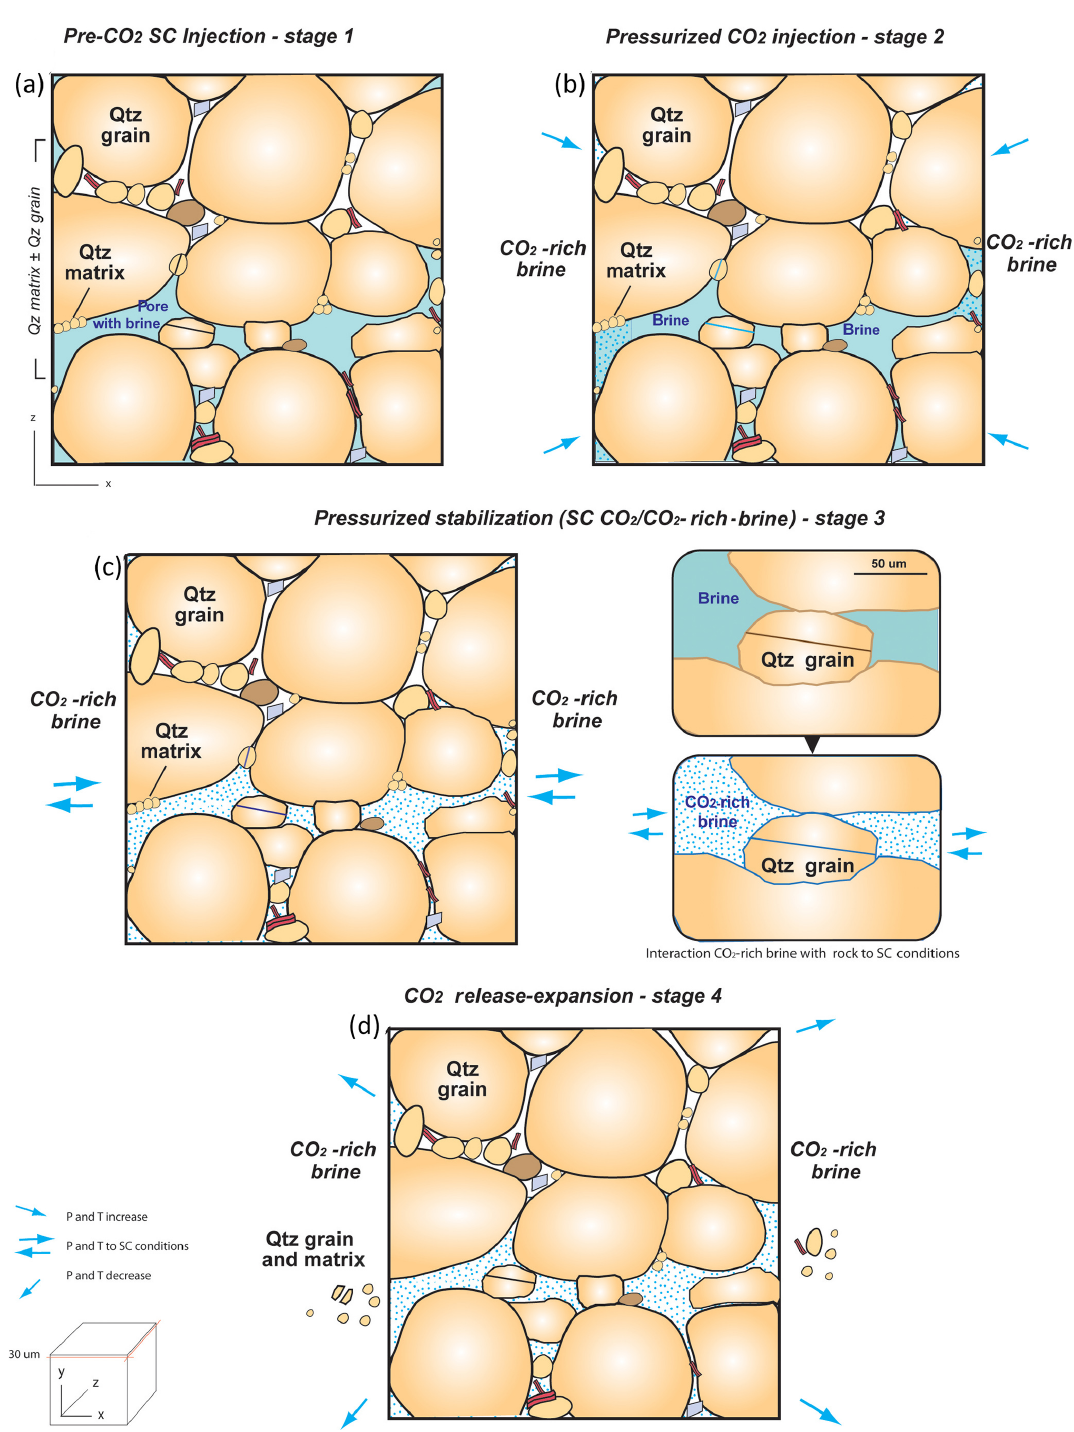
Figure 8. Scheme of a simplified model developed from the observed mineralogical/textural changes after the SC CO 2 injection in the Utrillas sandstones. As a summary, (a) initial mineralogy and texture of the sandstones: quartz is the 95% of the rock sample and brine filling intergranular spaces. (b) When the pressurized SC CO 2 injection begins, the injected gas acidified the brine (CO 2 -rich brine) and it interacts with the rock and the brine that is inside the pore network. (c) During supercritical experimental stage, the pressurized CO 2 -rich brine and brine interact under SC conditions producing instability in the original rock cohesion probably due to local chemical changes. (d) Released pressure at the end stage of the experiment may produce the leaks of quartz particles and matrix.